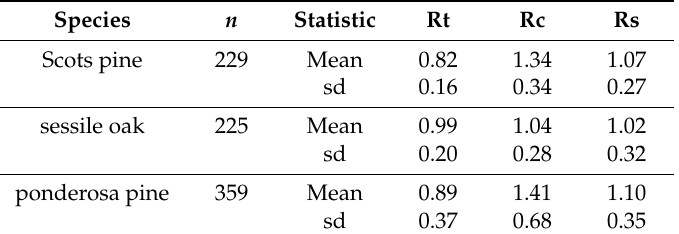
Table 2. Mean values and standard deviation ( sd ) of species-specific resistance ( Rt ), recovery ( Rc ), and resilience ( Rs ) indices. Means are calculated for each species over selected site-specific drought events based on standardized basal area increment indices. n = number of observations. Species n Statistic Rt